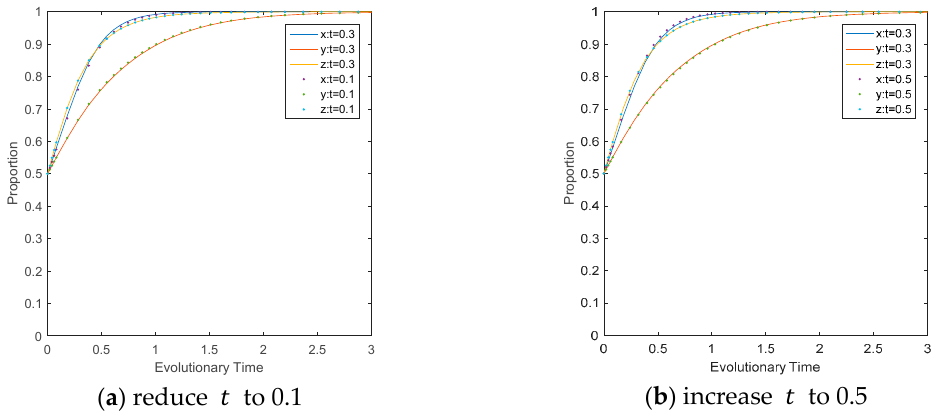
Figure 5. Impact of 𝑡 on the evolutionary path of multi-agents.